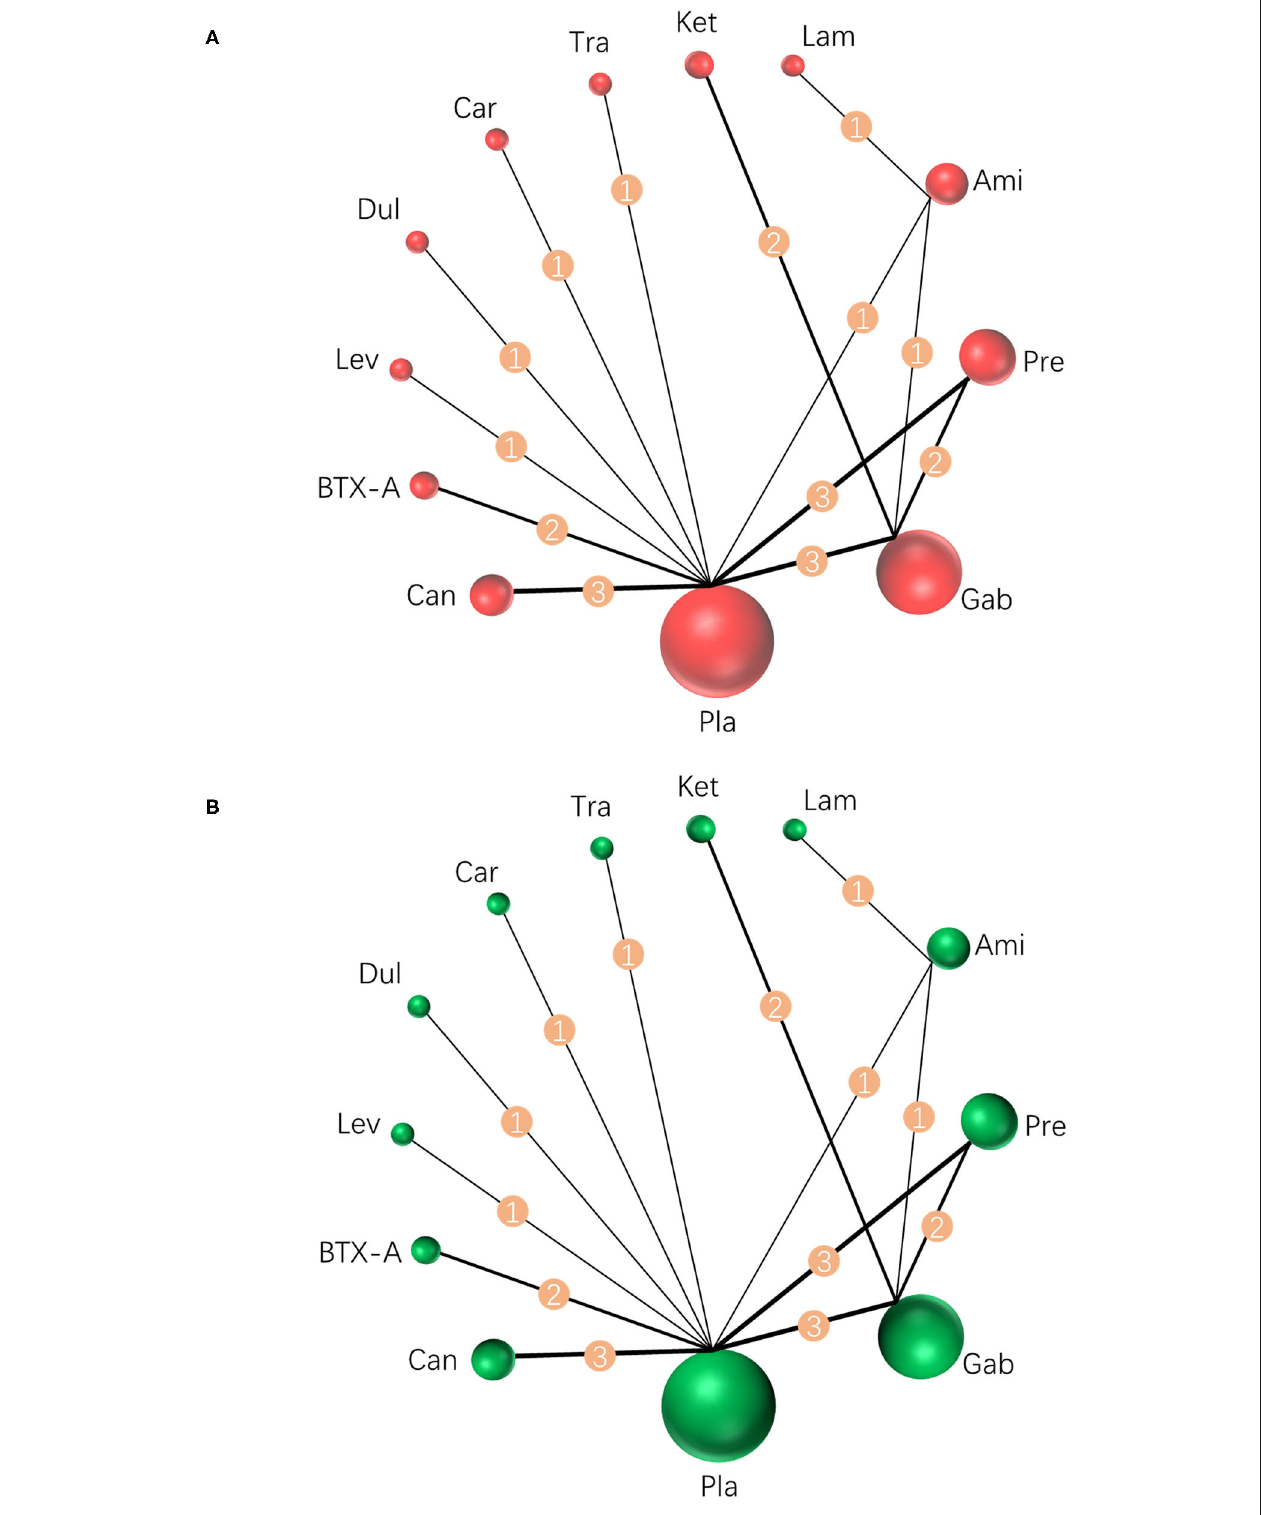
FIGURE 2 | Network meta-analysis of eligible comparisons for primary outcomes. (A) Pain relief for around 4 weeks, n = 1,207. (B) Any adverse events, n = 1,232. Width of the lines is proportional to the number of trials, comparing every pair of treatments (numbers on the lines). Size of every circle is proportional to the number of randomly assigned participants (sample size). BTX-A, botulinum toxin-A; Ket, ketamine; Ami, amitriptyline; Lam, lamotrigine; Pre, pregabalin; Dul, duloxetine; Gab, gabapentin; Tra, tramadol; Lev, levetiracetam; Car, carbamazepine; Can, cannabinoids; Pla, placebo.